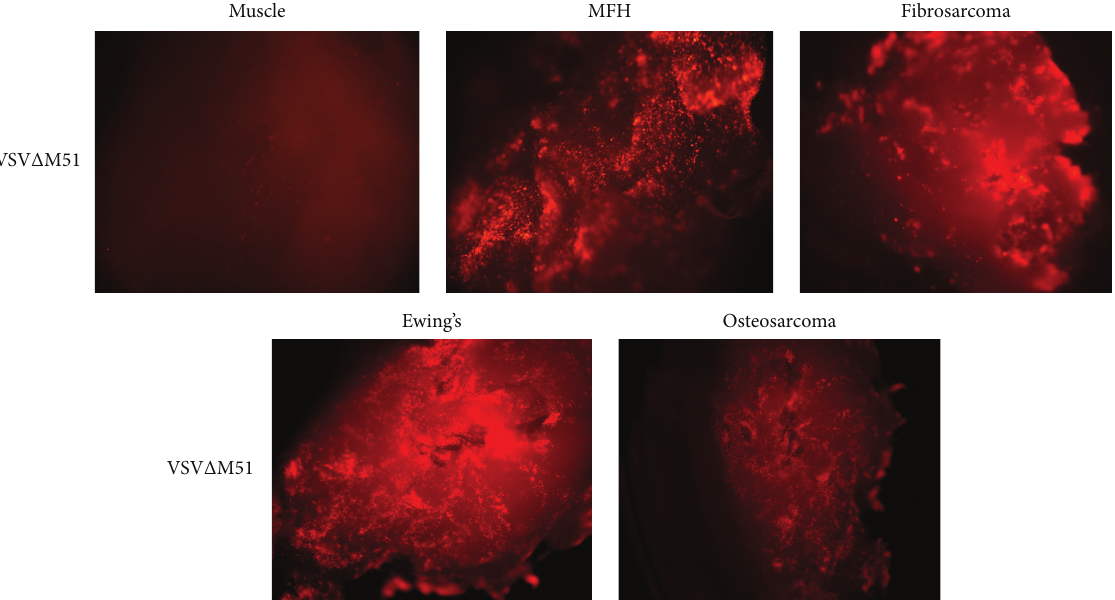
Figure 8: VSV Δ M51 infects multiple types of ex-vivo human sarcomas. Approximately 50% of the ex-vivo specimens tested are susceptible to VSV Δ M51